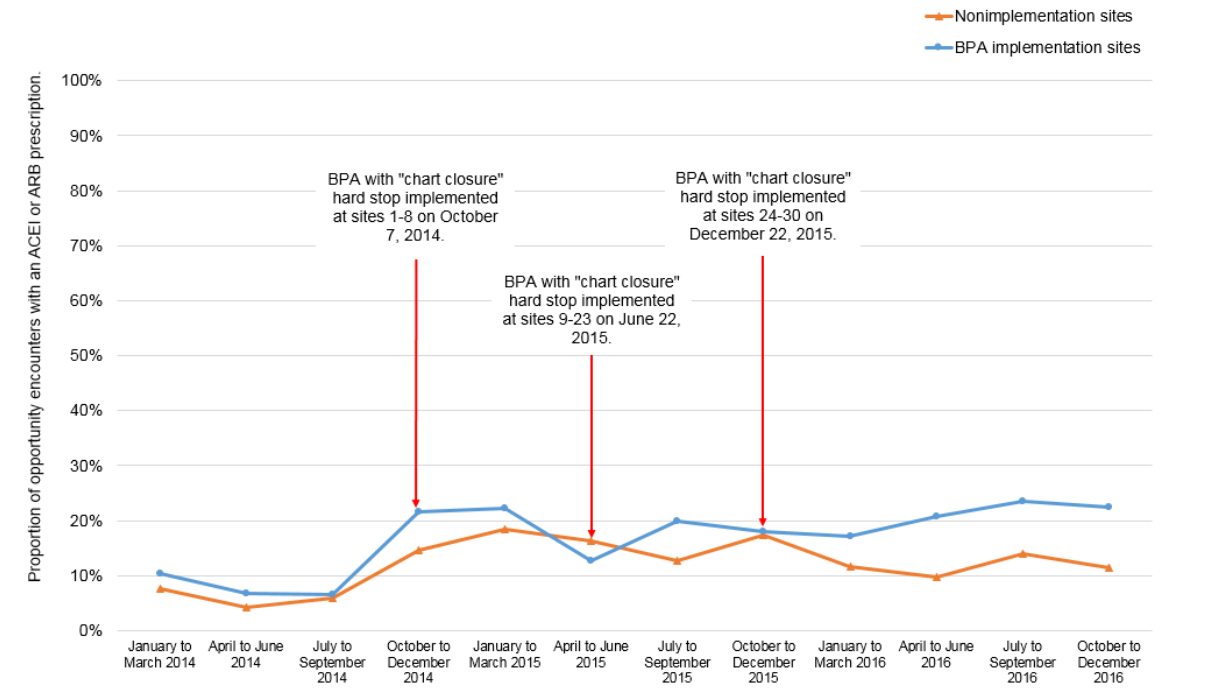
Figure 5. Proportion of opportunity encounters with an angiotensin-converting enzyme inhibitor or angiotensin-receptor blocker prescription in Best Practice Advisory implementation and nonimplementation sites throughout the study period. ACEI: angiotensin-converting enzyme inhibitor; ARB: angiotensin-receptor blocker; BPA: Best Practice